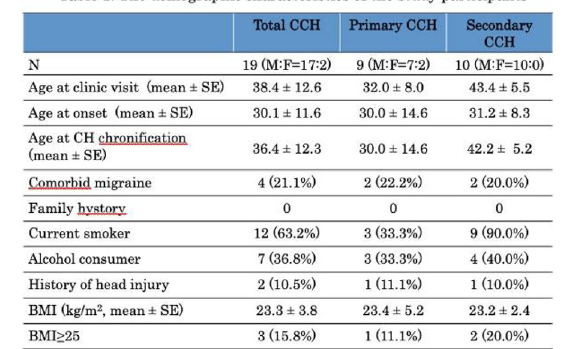
Table 1 (abstract P01). See text for description